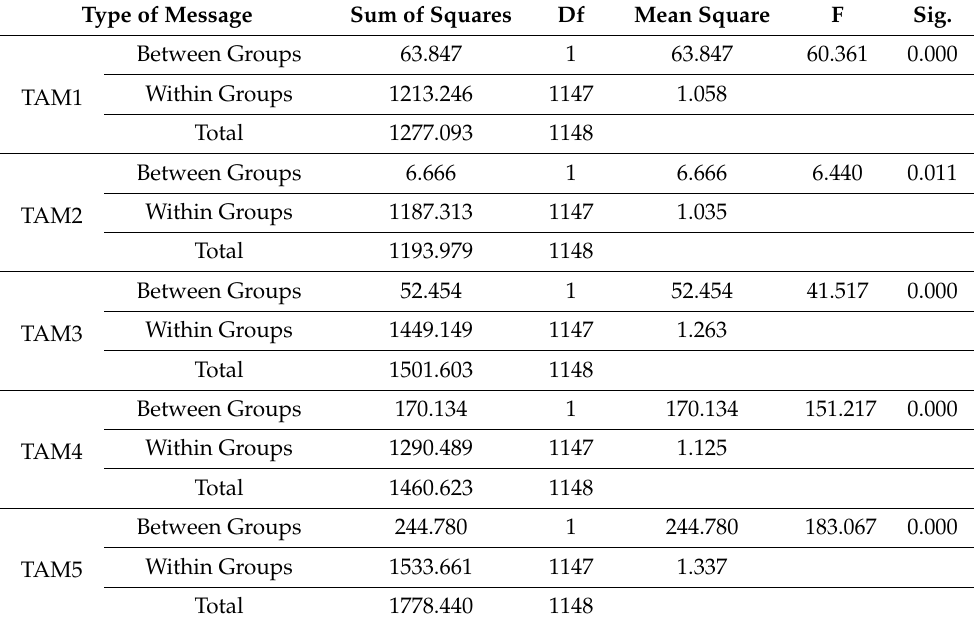
Table 9. ANOVA analysis result for hypothesis (H2b). Type of